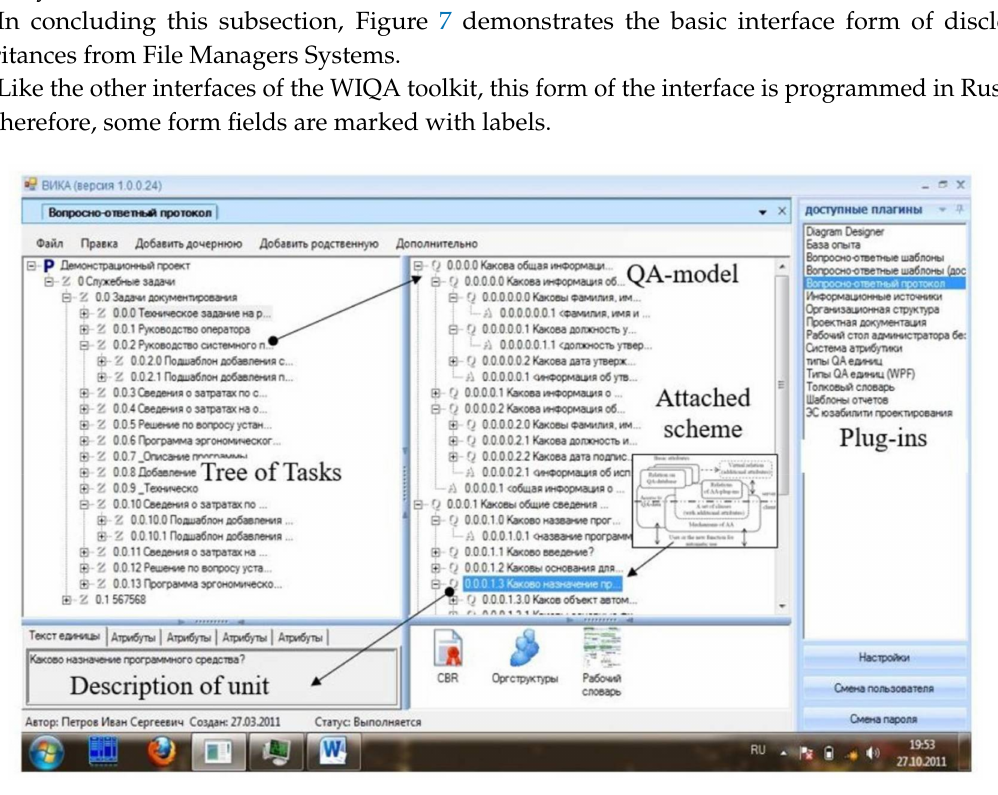
Figure 7. Basic interface form for visual interactions of the designer with